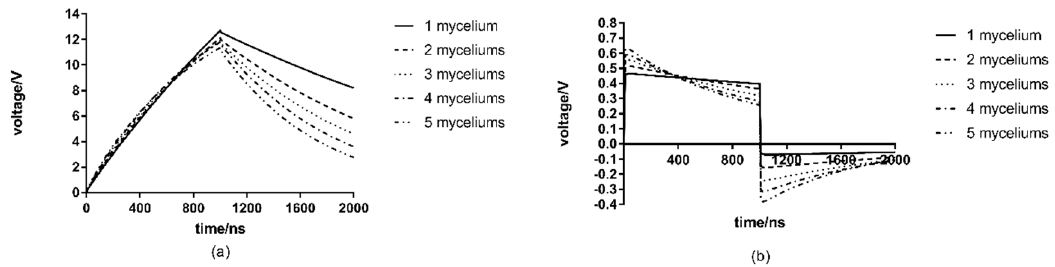
Figure 7. Effects of the number of hyphae on the transmembrane voltage: ( a ) cell membrane transmembrane voltage ( b ) nuclear membrane transmembrane voltage.